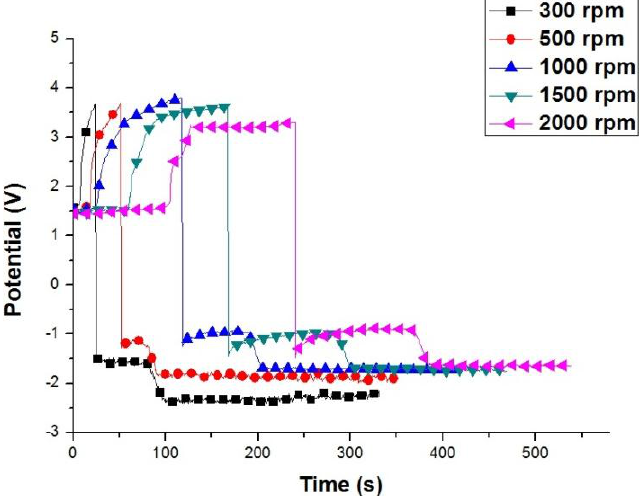
Figure 3. Potential variation of the AZ80 RCE at different rotation speeds during galvanostatic etching at the current density of 20 mA·cm −2 followed by